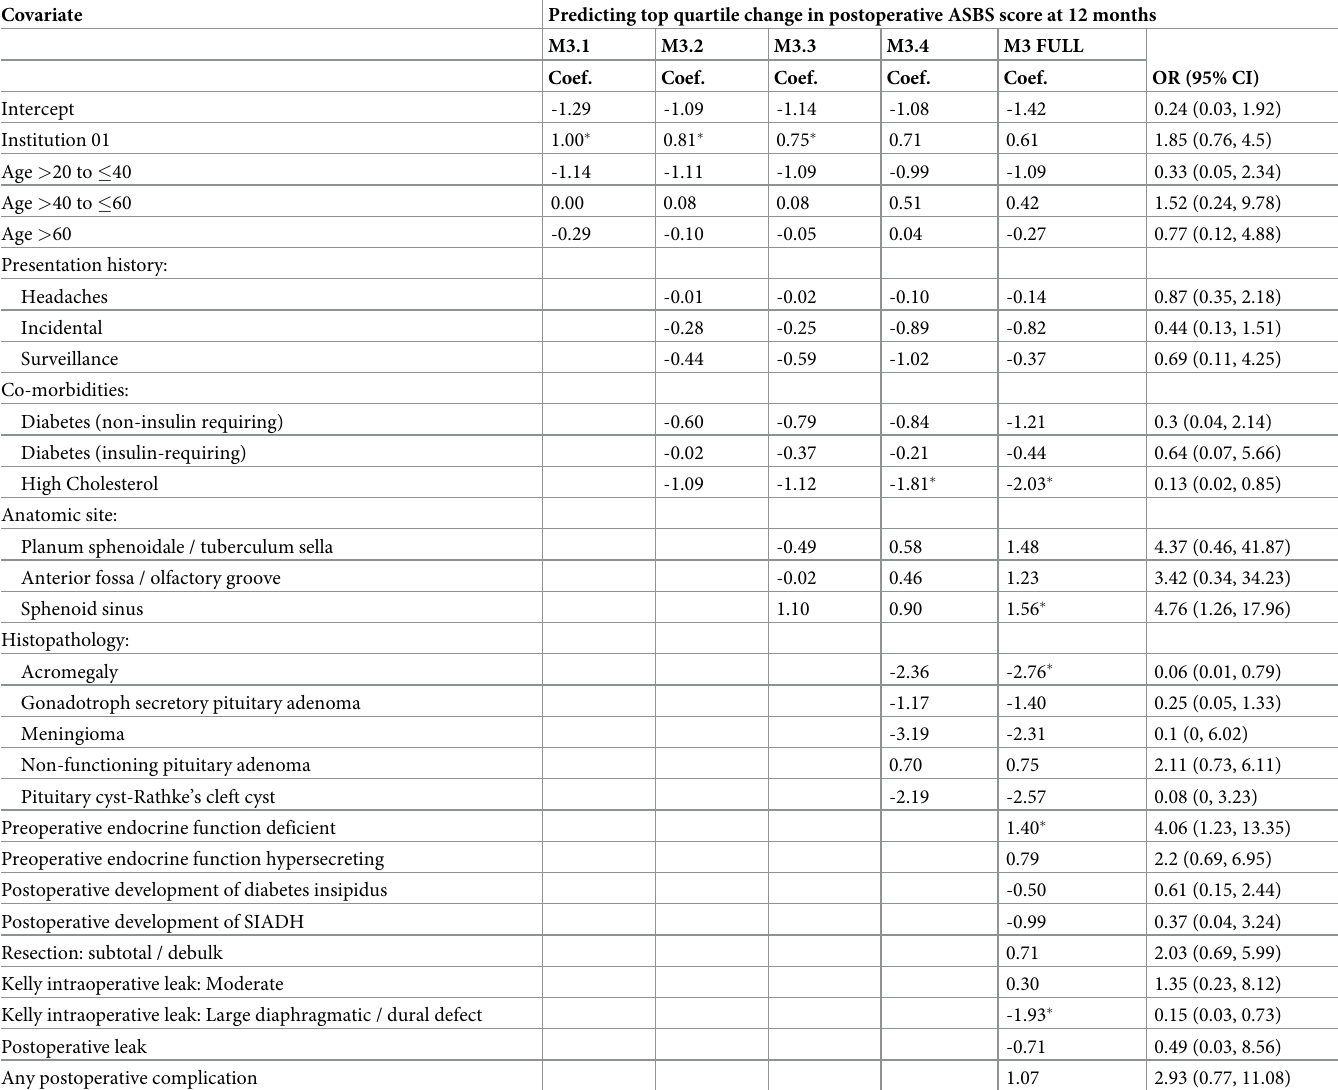
Table 3. Multivariate logistic regression showing associations between covariates and high positive changes in postoperative ASBS quality of life scores at 12 months (highest quartile). � p < 0.05. �� p < 0.01. SIADH, syndrome of inappropriate antidiuretic hormone secretion. The MX.X numbers are model codes. M3.1 is the first iteration of model 3, M3.2 is the second iteration of model 3, and so on. The M3 FULL model contains all covariates. Covariate Predicting top quartile change in postoperative ASBS score at 12